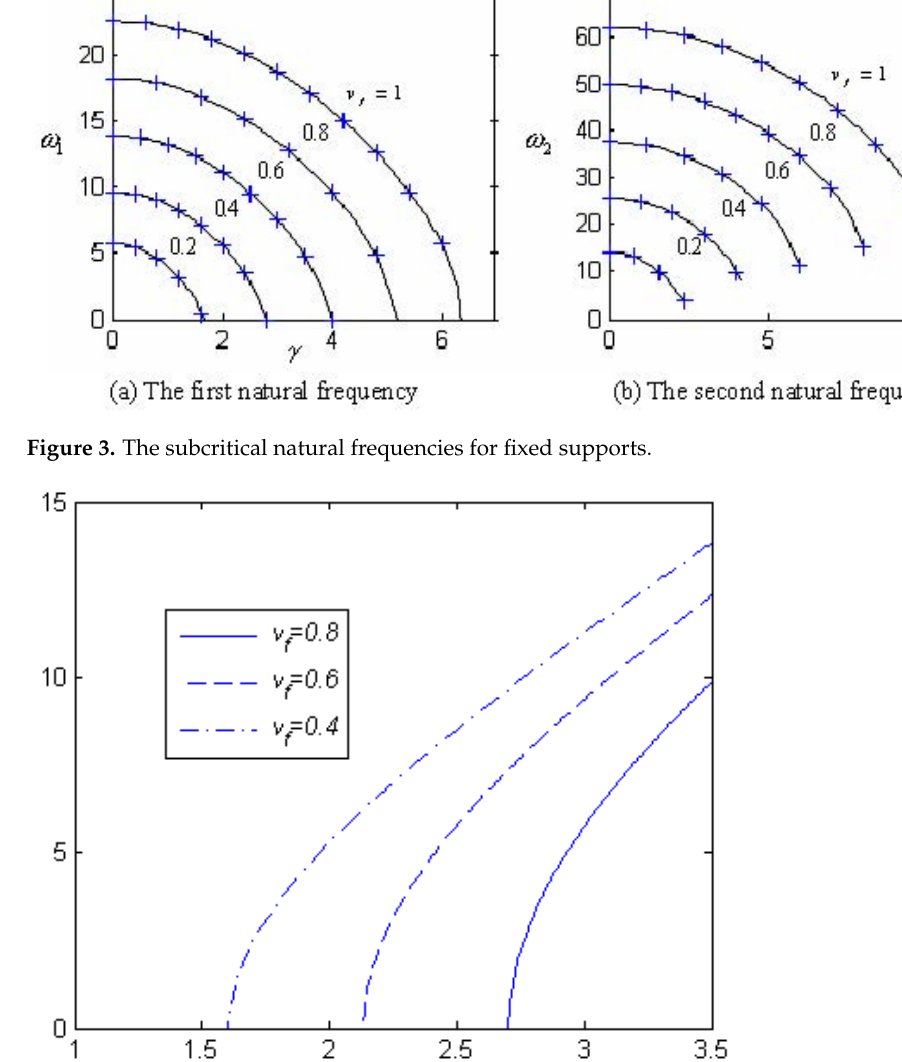
Figure 3. The subcritical natural frequencies for fixed supports.